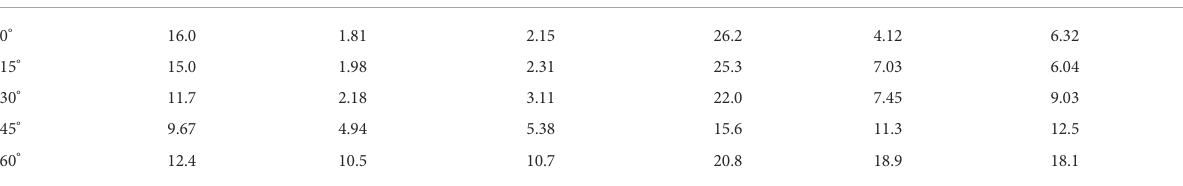
TABLE1Meanandmaximumvaluesofre fl ectivity Rasafunctionofangleofincidenceforuniform,sinusoidalandtriangularpro fi les.Theconsidered frequency ranges from 30 to 100